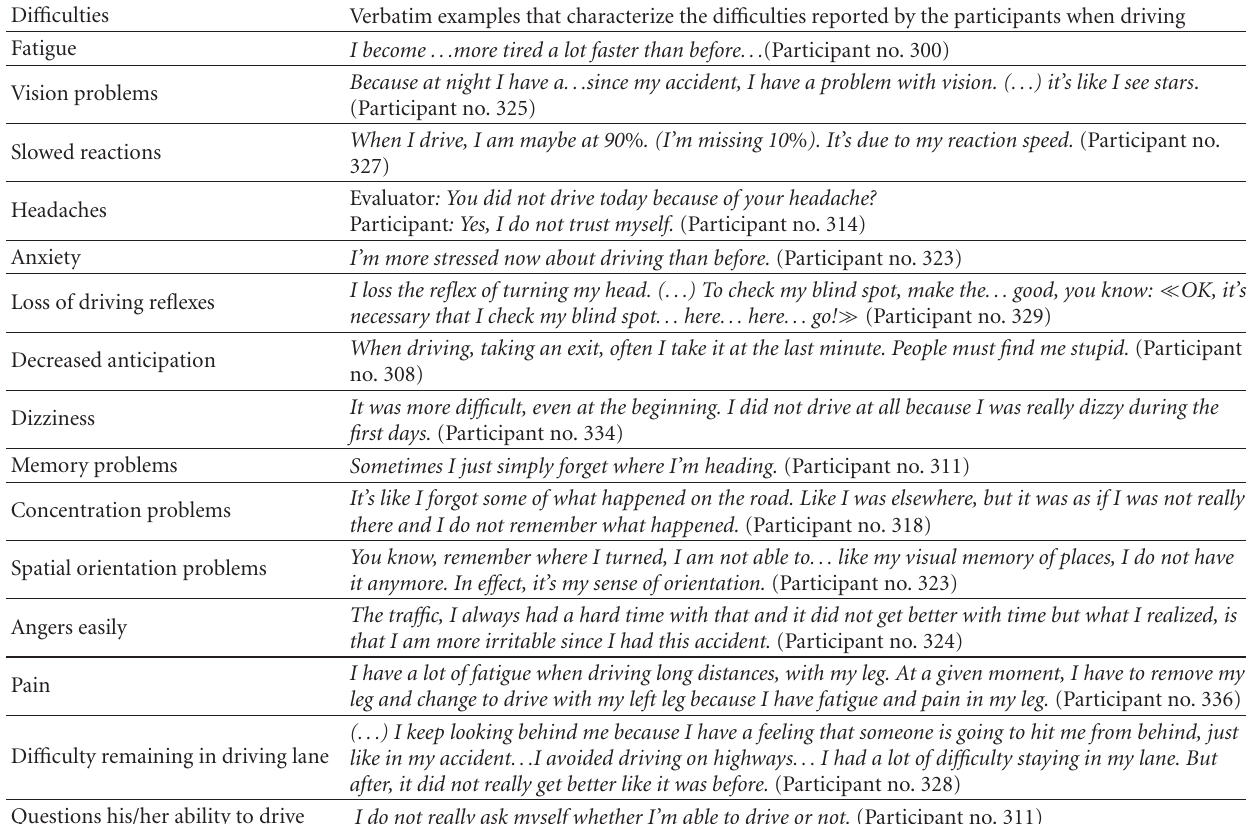
Table 3: Examples of di ffi culties reported by the participants and their perceived repercussions on driving. Di ffi culties